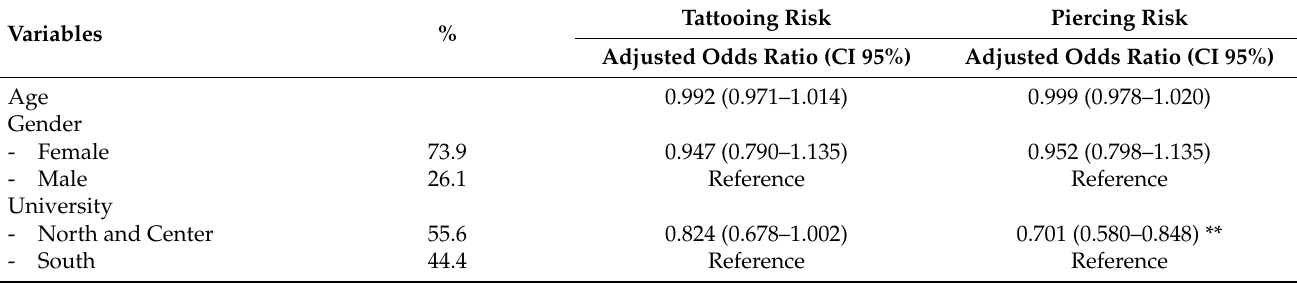
Table 4. Logistic regression analysis of variables related to poor knowledge of tattooing and piercing